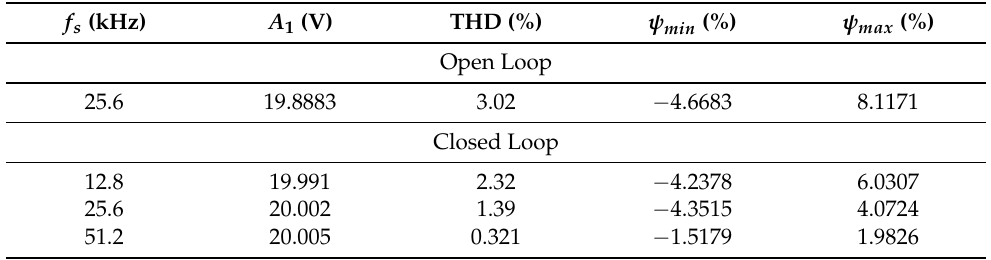
Figure 20. Output voltages v out ( t ) and load currents i ( t ) under abruptly changing resistive load for three sampling rates. Top row: uncontrolled system; bottom row: PID control tuned to the rectifier load with ∆ A = 1.1 Blue lines: PWM simulation, Green lines: QCT simulation. Table 4. Amplitude A 1 , THD, and the extreme values of distortion ψ ( t ) for the abruptly changing resistive